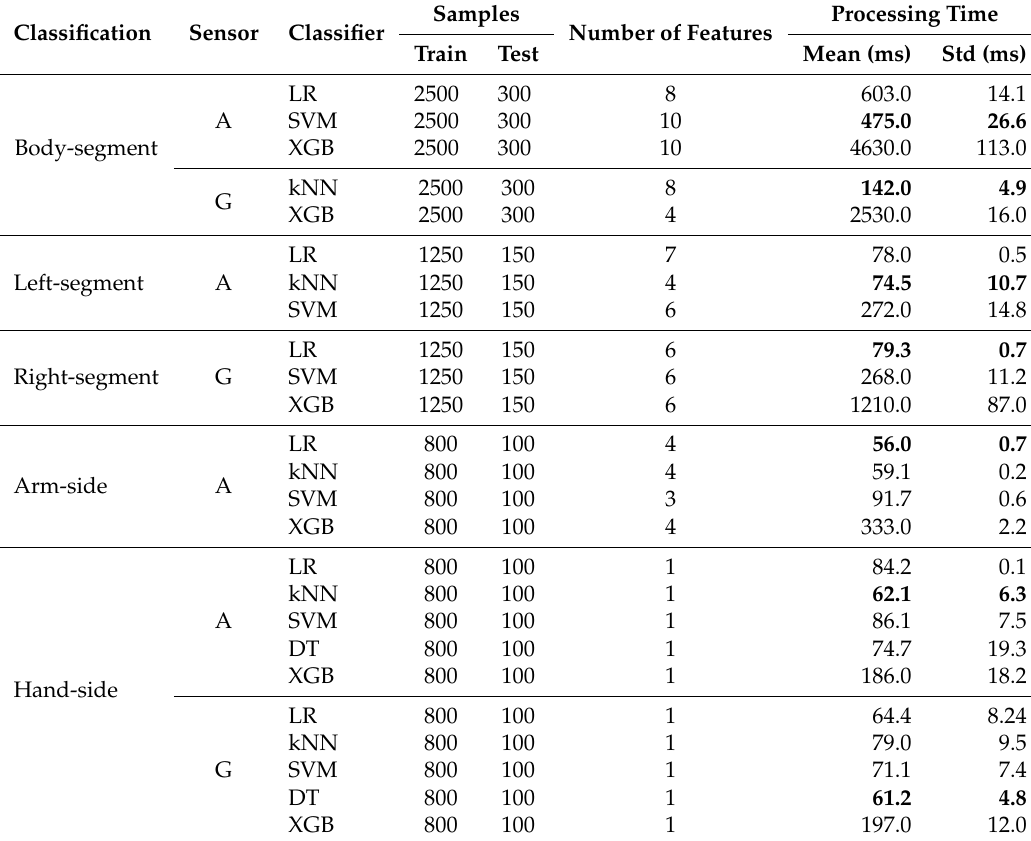
Table 6. Processing time of classifiers that have similar